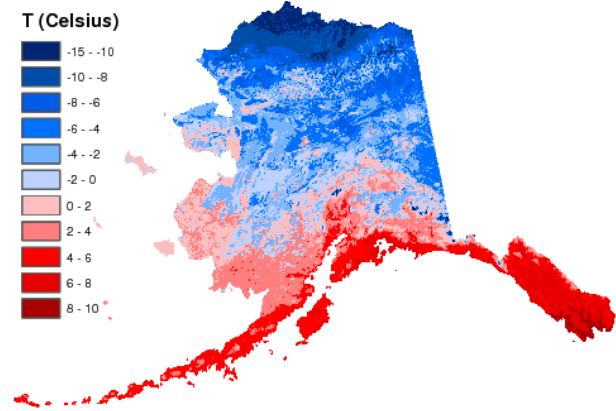
Fig. 8. Simualted mean annual ground temperatures at 1m depth for the year